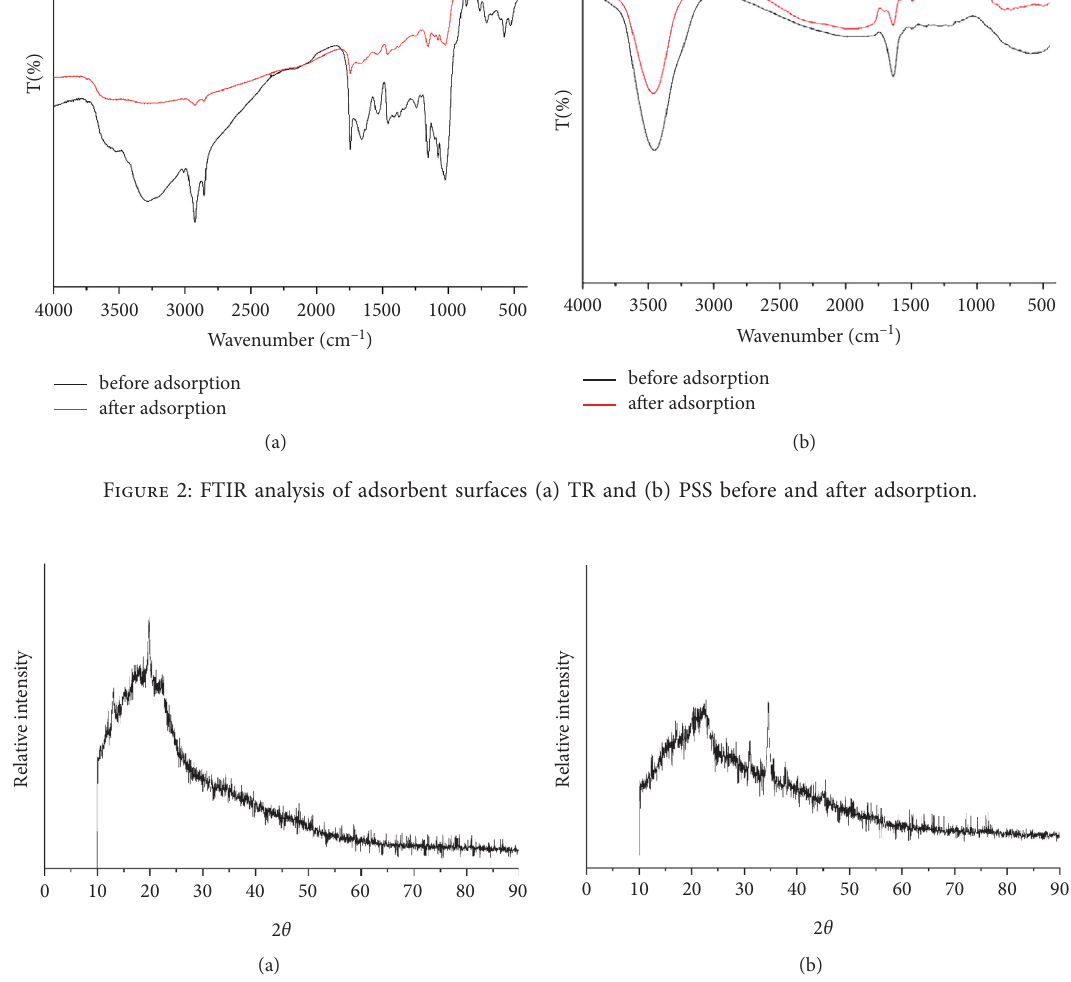
Figure 3: XRD data of (a) TR and (b) PSS and after